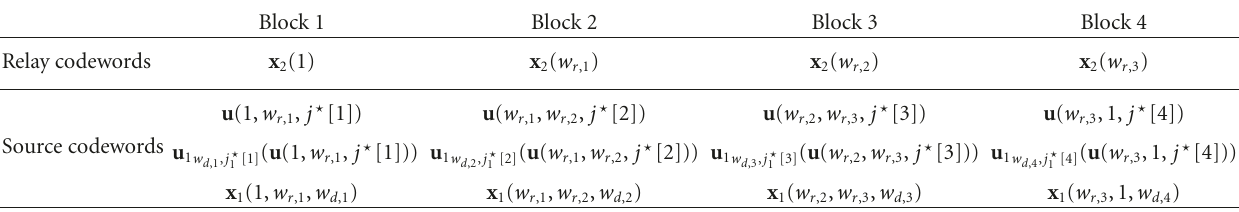
Table 1: Regular encoding for the state-dependent RC with informed source with rate-splitting. At the beginning of block i , the relay sends x 2 ( w r , i − 1 ) and the source sends a vector x 1 ( w r , i − 1 , w r , i , w d , i ) with i.i.d. components given x 2 ( w r , i − 1 ) , u ( w r , i − 1 , w r , i , j (cid:3) [ i ]) ,